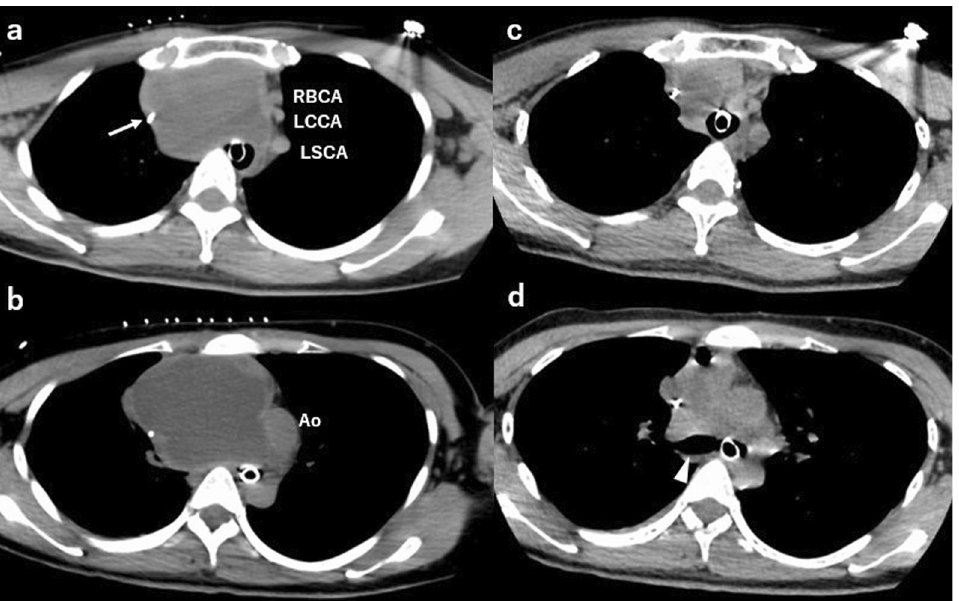
Fig. 2 Comparison of CT images before and after drainage. A double-lumen tube was intubated into the left main bronchus. Central venous catheter was inserted from the right internal jugular vein (white arrow). The images a and b were taken before drainage. The images c and d were taken after drainage. The images a and c are at the trachea level and images b and d are at the level of carina of the trachea. After drainage, the right main bronchus was patent (white arrowhead). CT computed tomography, RBCA right brachiocephalic artery, LCCA left common carotid artery,